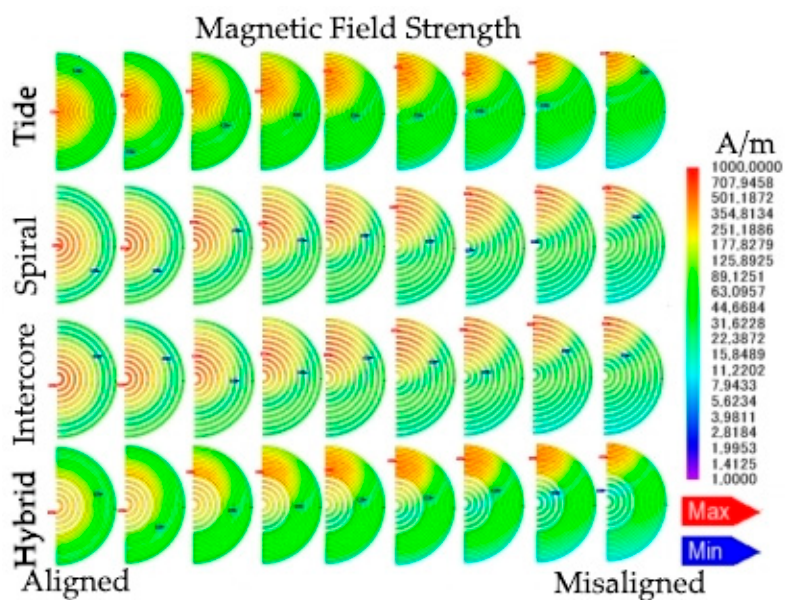
Figure 15. Magnetic field strength.